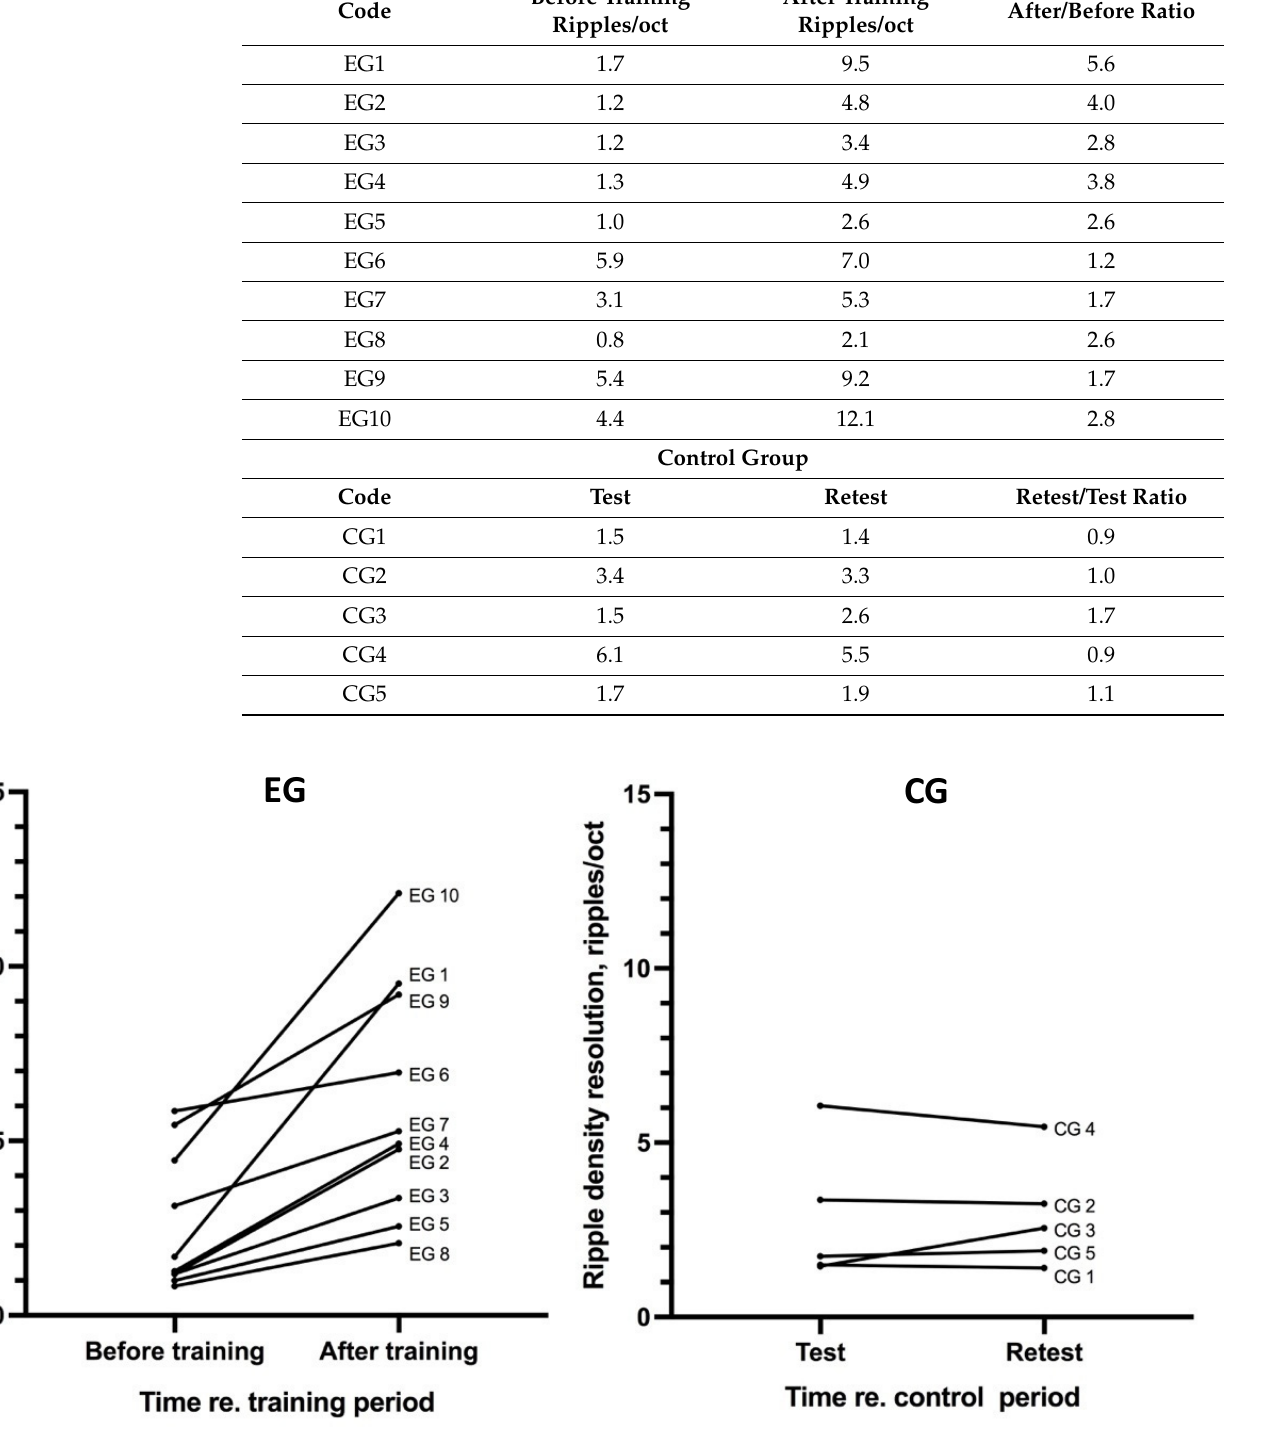
Figure 1. The ripple density resolution (ripples/oct) for the EG (before and after training) and CG (test/retest). Each line indicates the result of one CI user.